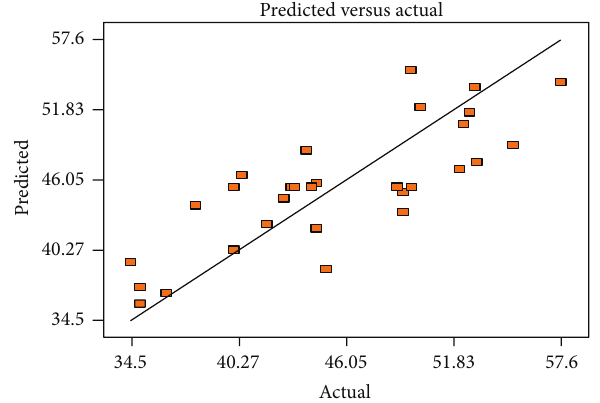
Figure 6: Plot of predicted versus actual NH 3 -N removal.